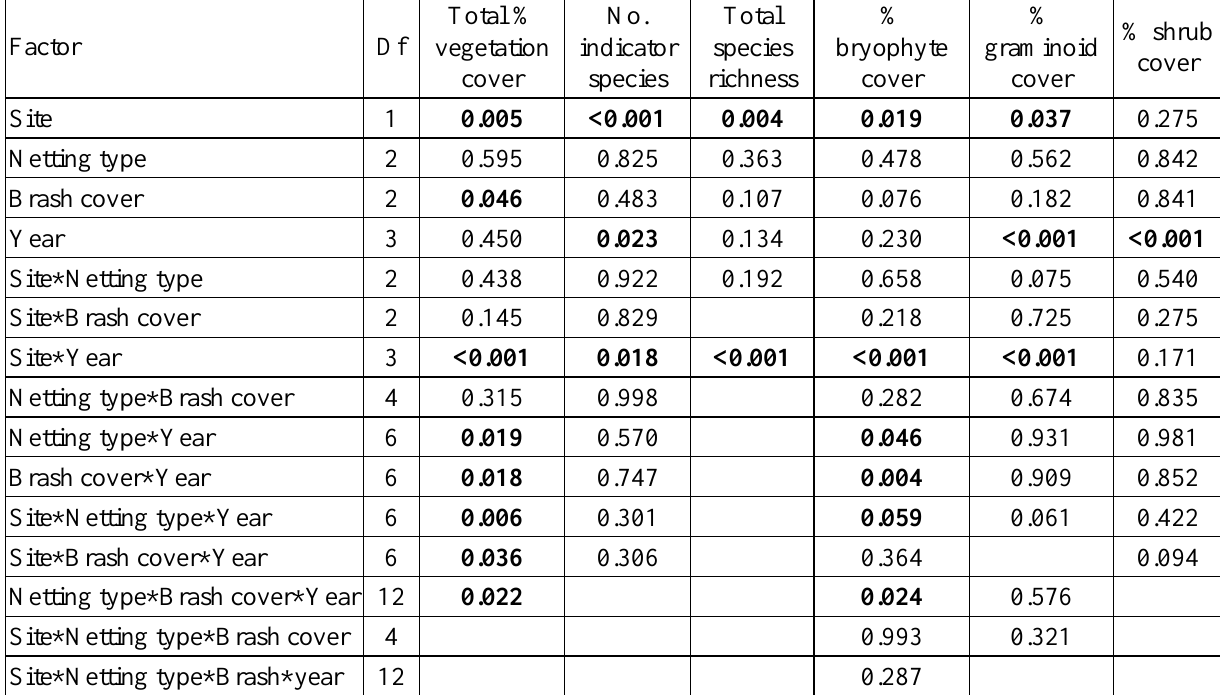
Table 2. The results of repeated measures mixed effects models (ANOVAs), showing P -values for percent vegetation, bryophyte, graminoid and shrub cover, number of indicator species and total number of species. Factors significant at the 95% confidence level are highlighted in bold. Non-significant interactions have been removed using Akaike Information Criterion to give the best fitting model to the